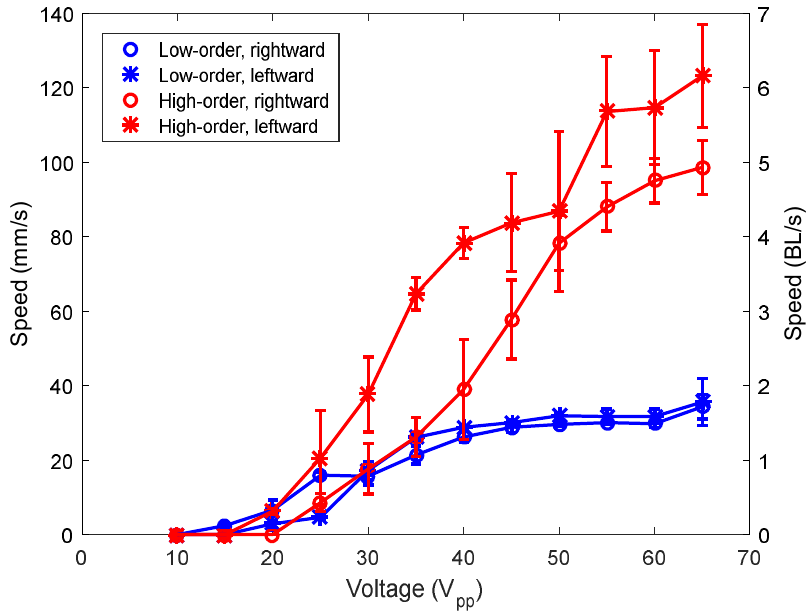
Figure 6. Speed of the robots (average of 5 measurements) versus applied voltage for the low-order (blue) and the high-order (red) combinations.